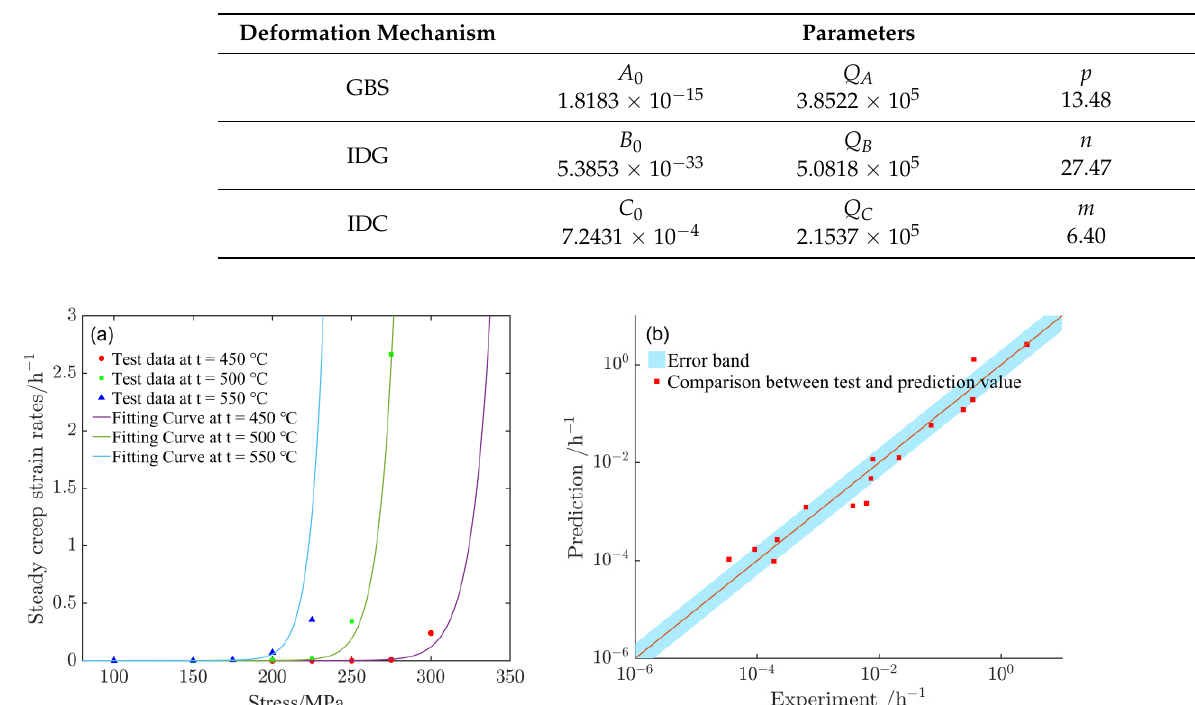
Figure 7. Comparison of predicted and experimental values for the minimum creep rate of CGI. ( a ) Comparison of predicted curves with experimental values, and ( b ) comparison of predicted and experimental values at twice the error.